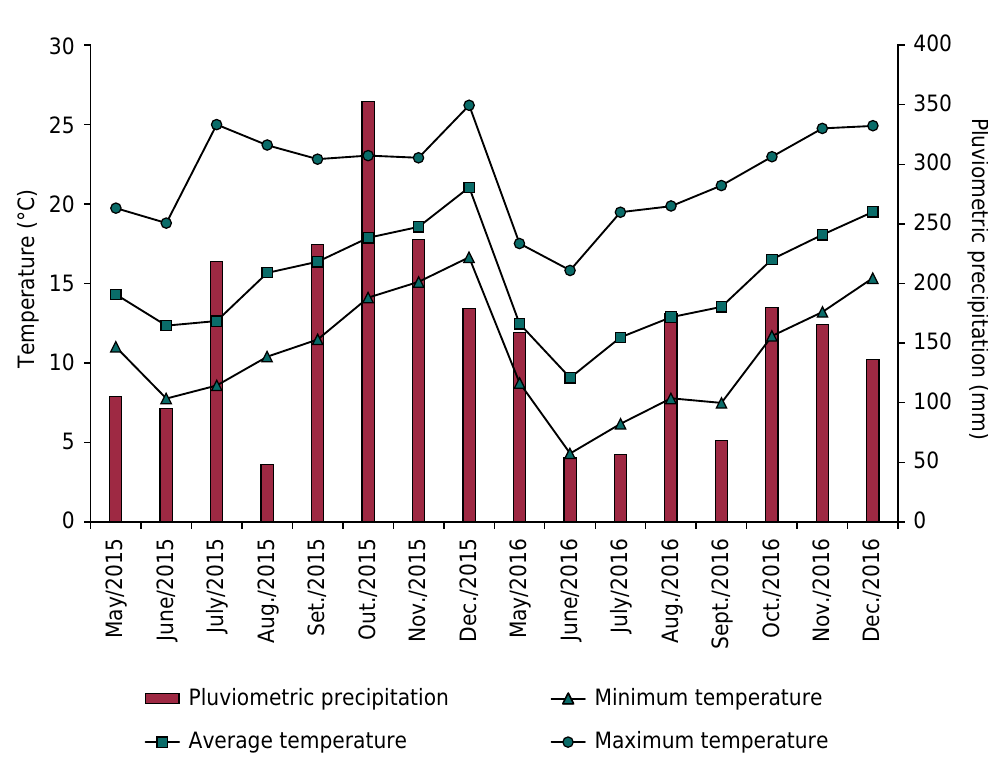
Figure 3. Precipitation, maximum temperature, minimum temperature, and average monthly temperature during the period the experiments were